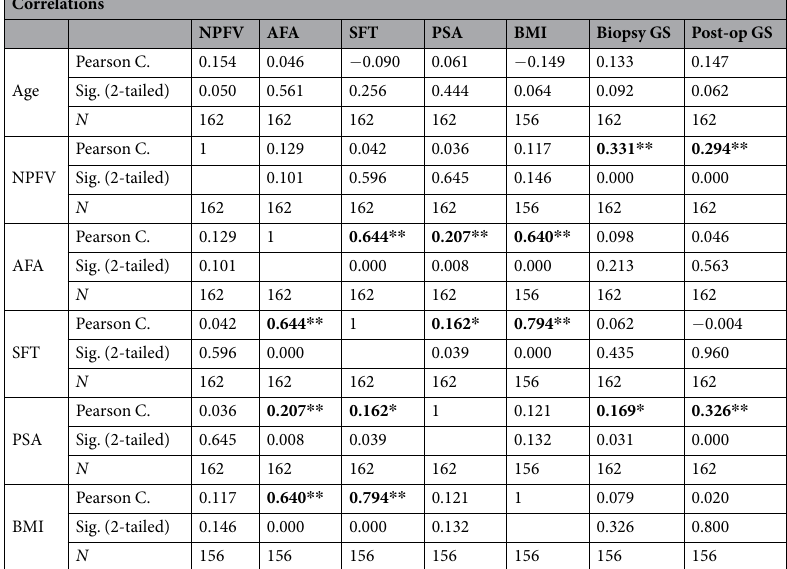
Table 4. The relationship between post RP Gleason score, age, body mass index (BMI), prostate-specific antigen (PSA) and different fat measurements using Pearson correlation coefficient. * Correlation is significant at the 0.05 level (2-tailed). ** Correlation is significant at the 0.01 level (2-tailed). NPFV = Normalised periprostatic fat volume; AFA = Abdominal fat area; SFT = Subcutaneous fat thickness; PSA = Prostate specific antigen; BMI = Body mass index; GS = Gleason